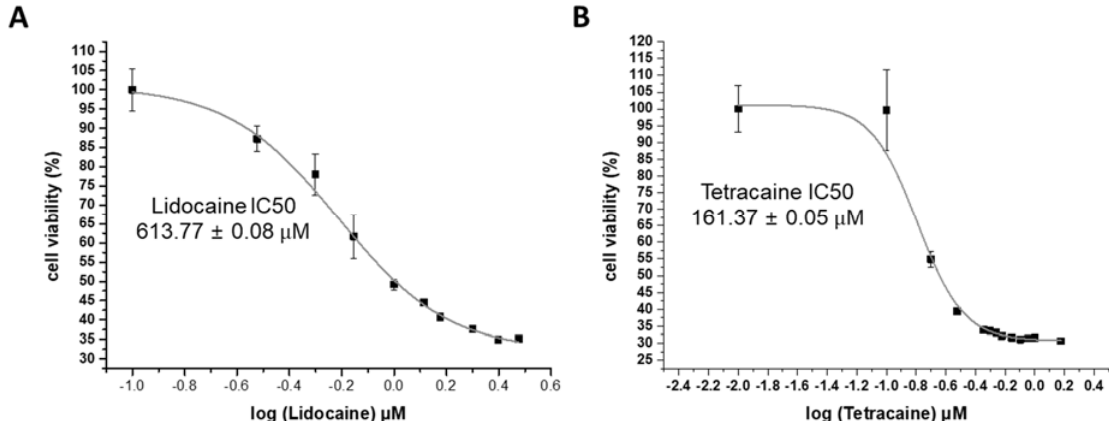
Figure 3. CCK-8 assay to analyze cell cytotoxicity, ( A ) Lidocaine IC50 is 613.77 µM ( B ) Tetracaine IC50 is 161.37 µM . (n = 3, p < 0.001).